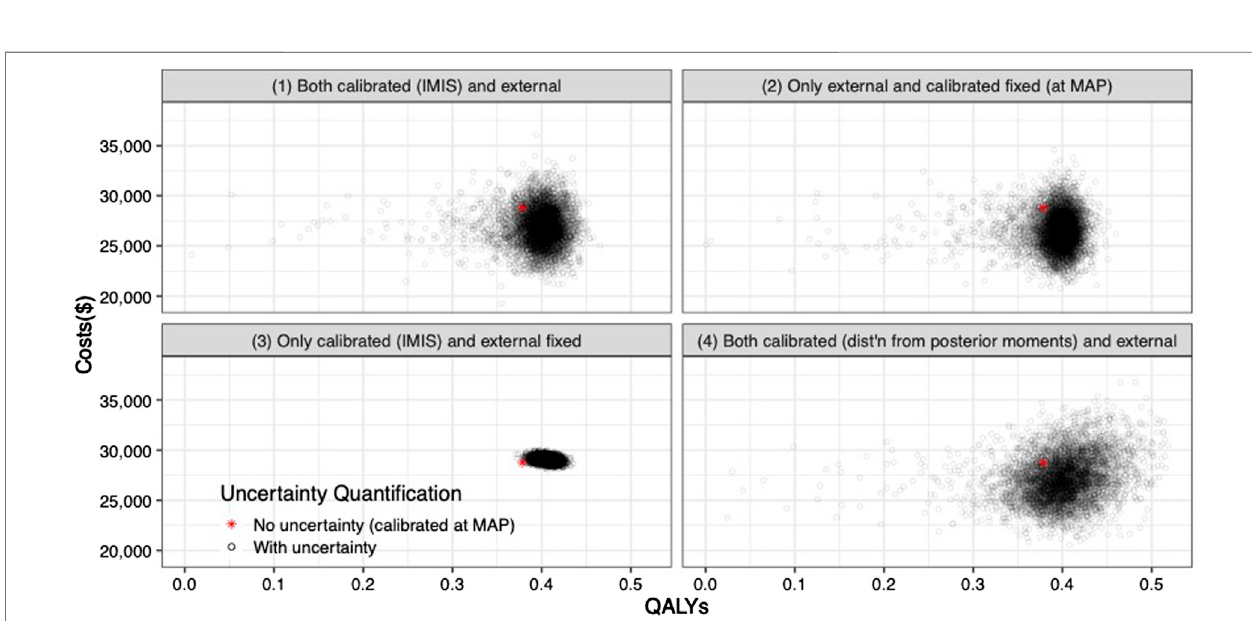
FIGURE 5 | Incremental costs and incremental QALYs of 10-years colonoscopy screening vs. no screening under different assumptions of characterization of the uncertainty of both calibrated and external parameters. The red star corresponds to the incremental costs and incremental QALYs evaluated at the maximum-a- posteriori estimate of the calibrated parameters and the mean values of the external parameters.